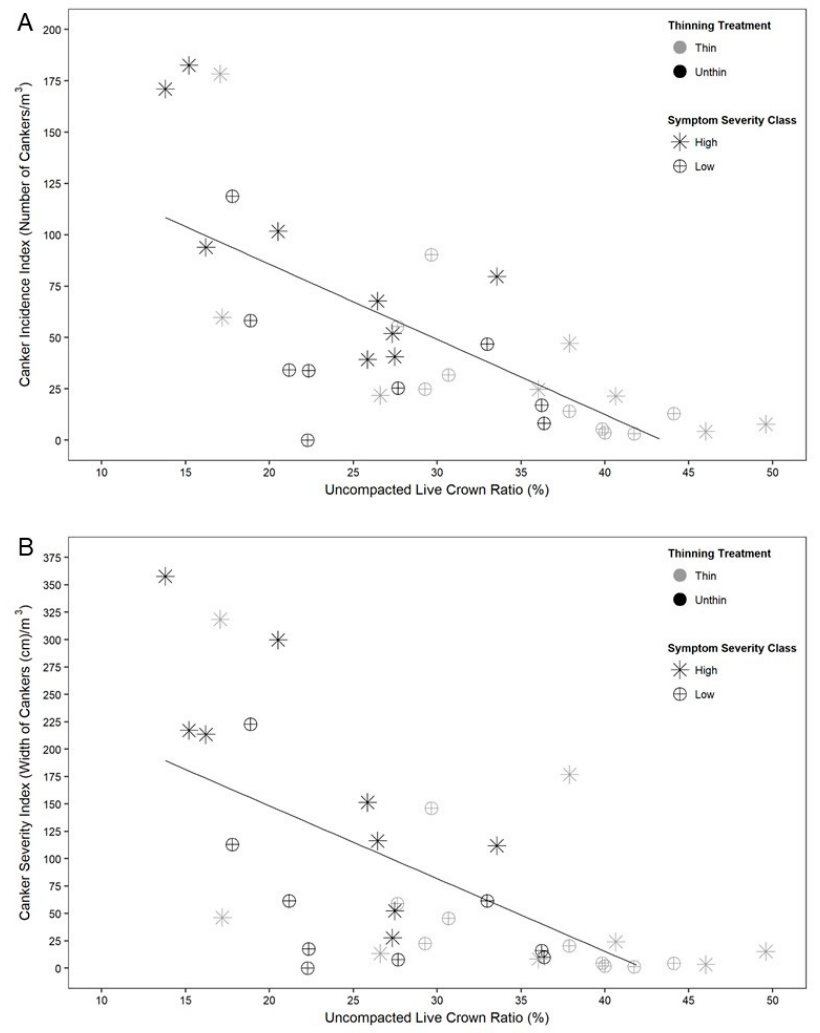
Figure 5. Canker incidence and severity measures associated with crown metrics. Linear mixed effects models were used to assess the relationship between uncompacted live crown ratio, ( A ) the canker incidence index (number of cankers / m 3 of tree; p -value < 0.001), and ( B ) the canker severity index (width of cankers / m 3 of tree; p -value = 0.002).